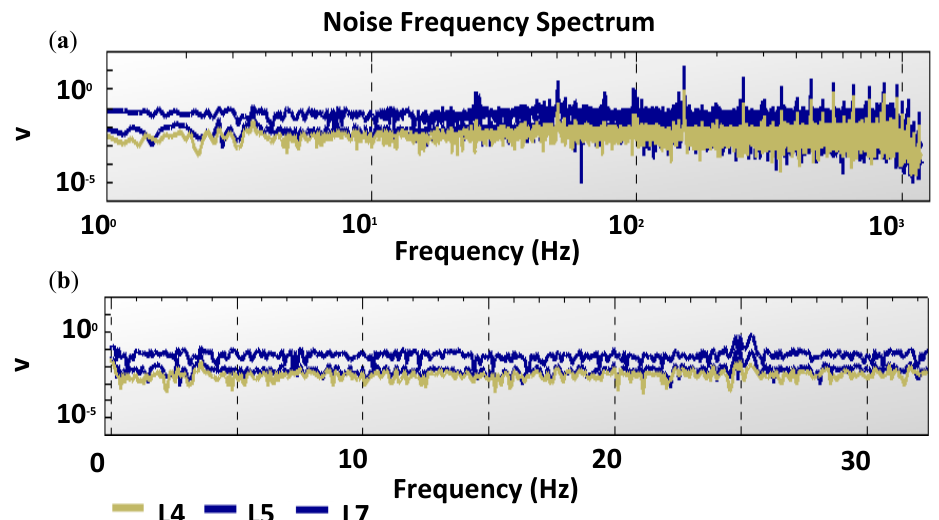
Figure A4. EM telemetry noise characteristics for dipoles L1, L2 and L3: ( a ) frequency spectrum of measured noisy data, and ( b ) frequency spectrum of recorded data for the frequency range of interest.